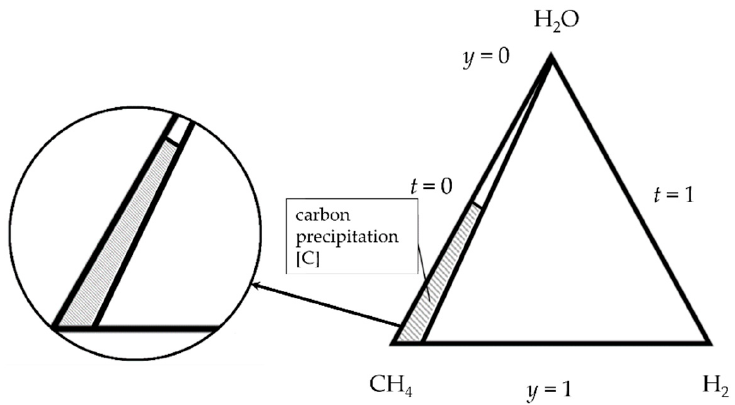
Figure 4. Range of carbon precipitation [C] = f ( t , y ) for T = 1000 K in system (CH 4 /H 2 )–H 2 O.